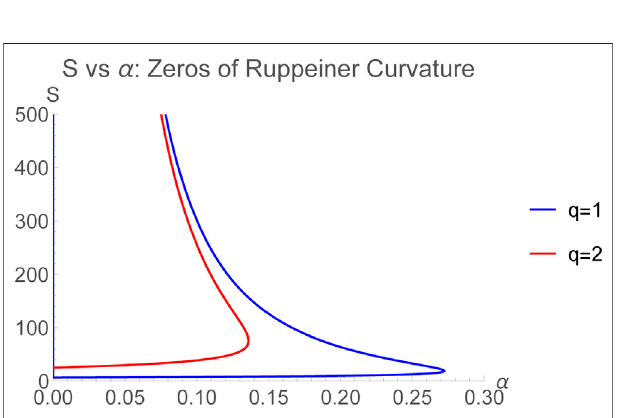
FIGURE 4 | Points in the parameter space where the Ruppeiner Curvature is fl at.